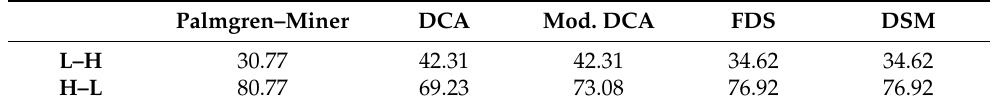
Table 3. Percentage of non-conservative model estimations ( n 2 P / N 2 > n 2 E / N 2 ) for each model, for the two-level block loading experiments. Exp = experiments, Est = model estimation